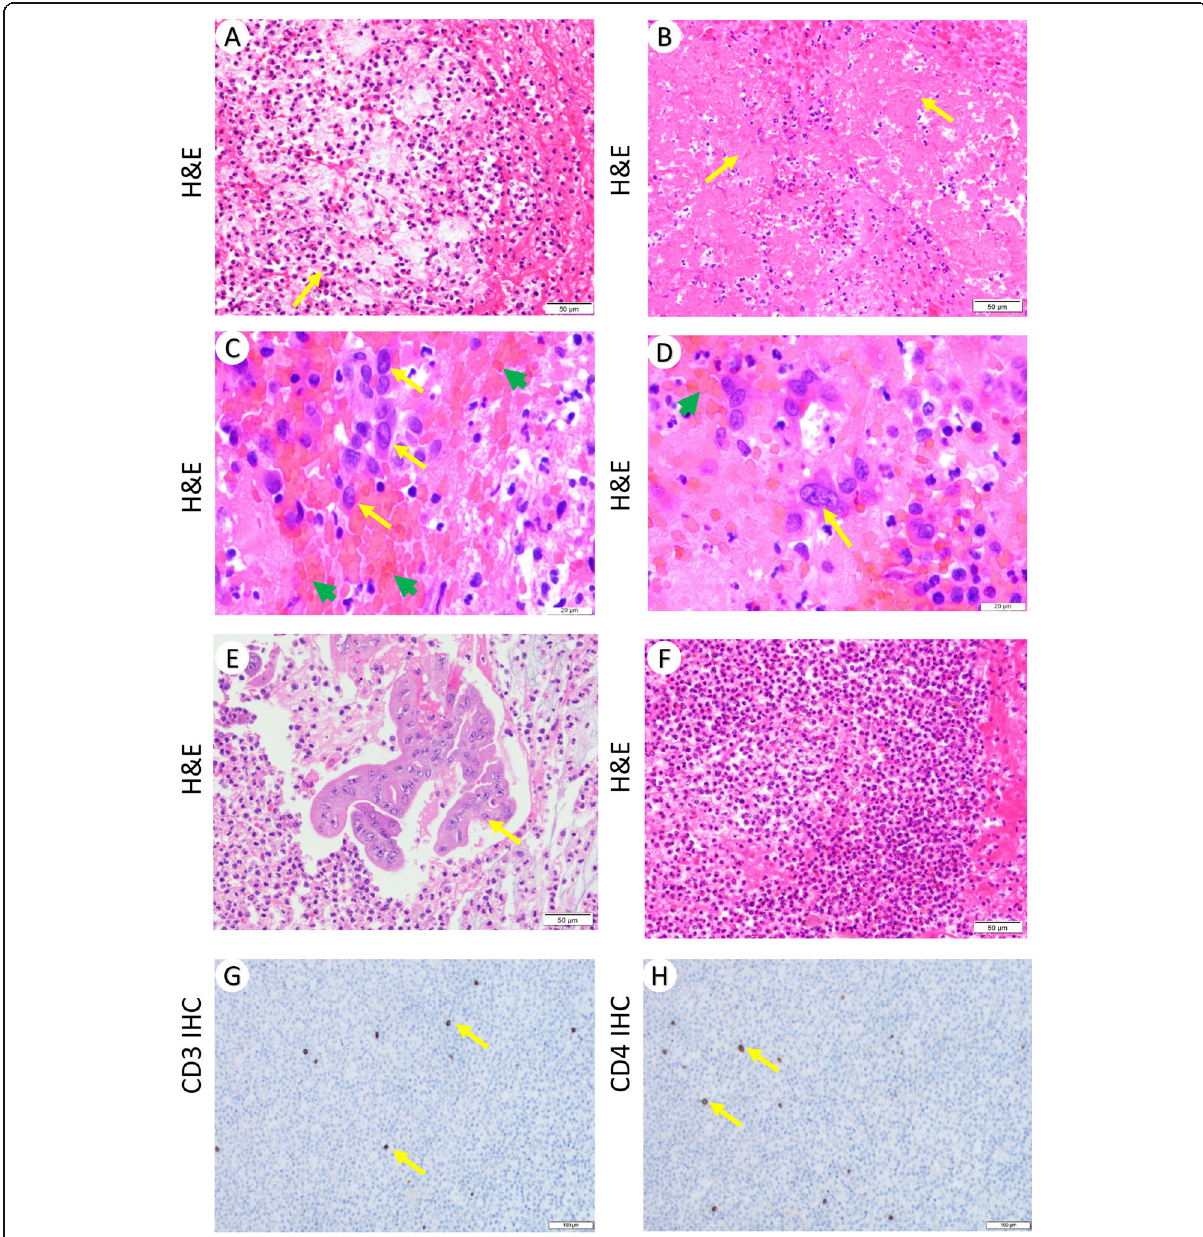
Fig. 1 Histopathological findings in the intestinal tissues. a Massive neutrophil infiltration accompanied by fibrin, erythrocyte and mucus exudation (200X). b focal inflammatory necrosis (200X); c - d enlarged nuclei and deep staining of macrophages (yellow arrow) with prominent nucleoli, focal hemorrhage accompanied by neutrophil and lymphocyte infiltration (400X). e residual glandular epithelial cells with hemorrhage necrosis, fibrin and mucus exudation (200X). f Focal purulent inflammation (200X). g Immunohistochemistry of CD3 (100X), h Immunohistochemistry of CD4